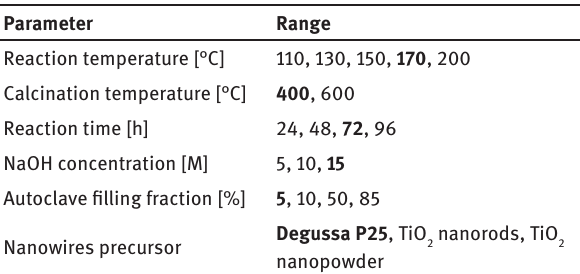
prepared at different Figure 2: XRD of TiO 2 Table 1: Modifications of the baseline preparation conditions (baseline parameters in bold).